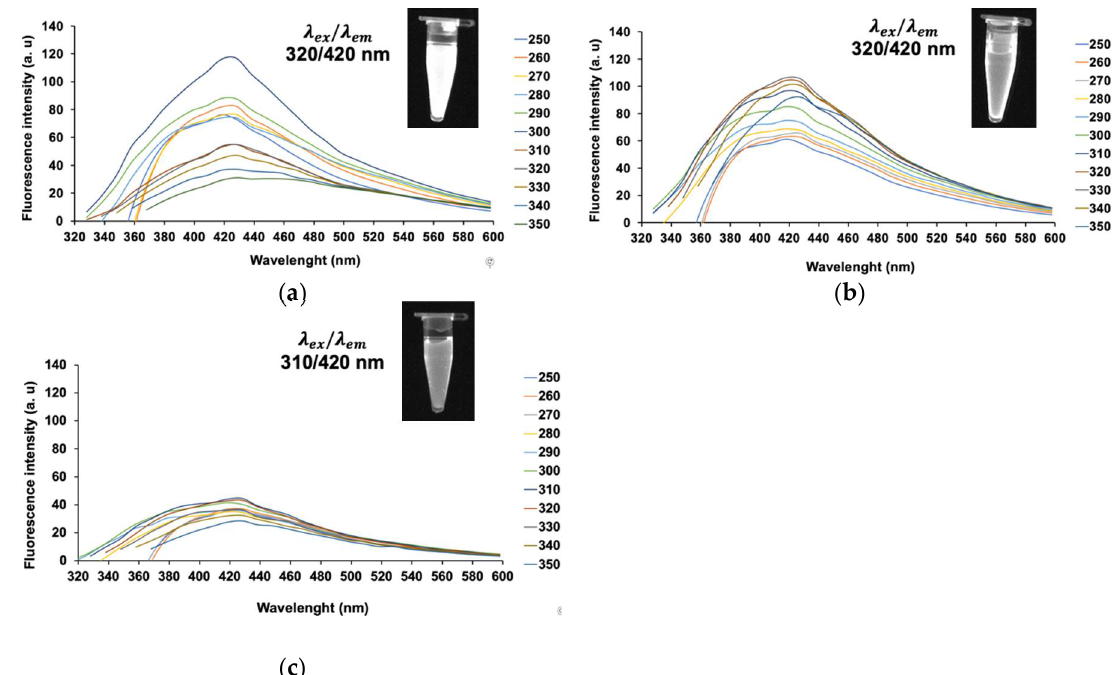
Figure 4. Emission spectra of C-Dots under different excitation wavelengths. ( a ) Picea . ( b ) Molinia caerulea . ( c ) Elaeis guineensis.